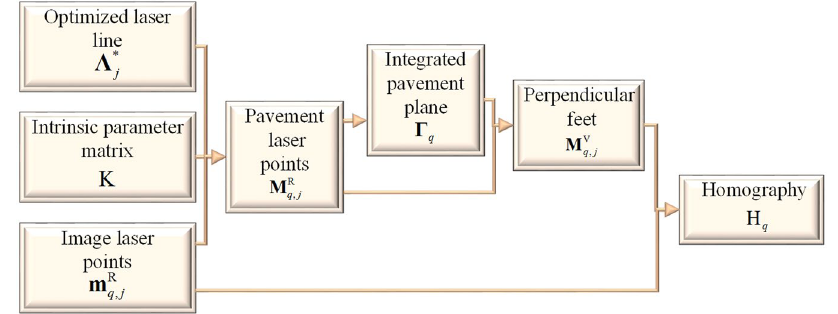
Figure 4. The active solution process of the homography on the basis of the four laser projection